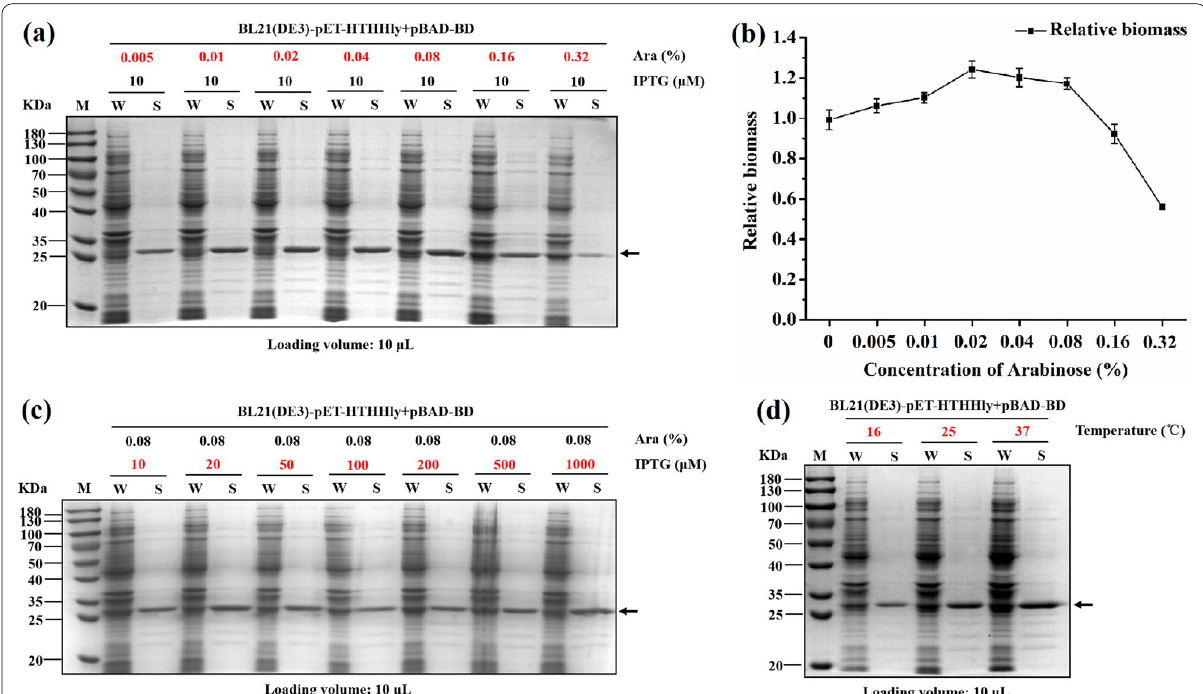
Fig. 3 Optimization of the Hly secretion system with HTHHly. a Effect of arabinose concentrations on secretion level. b Effect of arabinose concentrations on biomass. c Effect of IPTG concentrations on secretion level. d Effect of induction temperatures on secretion level. W whole-cell lysate, S supernatant. The arrows indicate the target protein